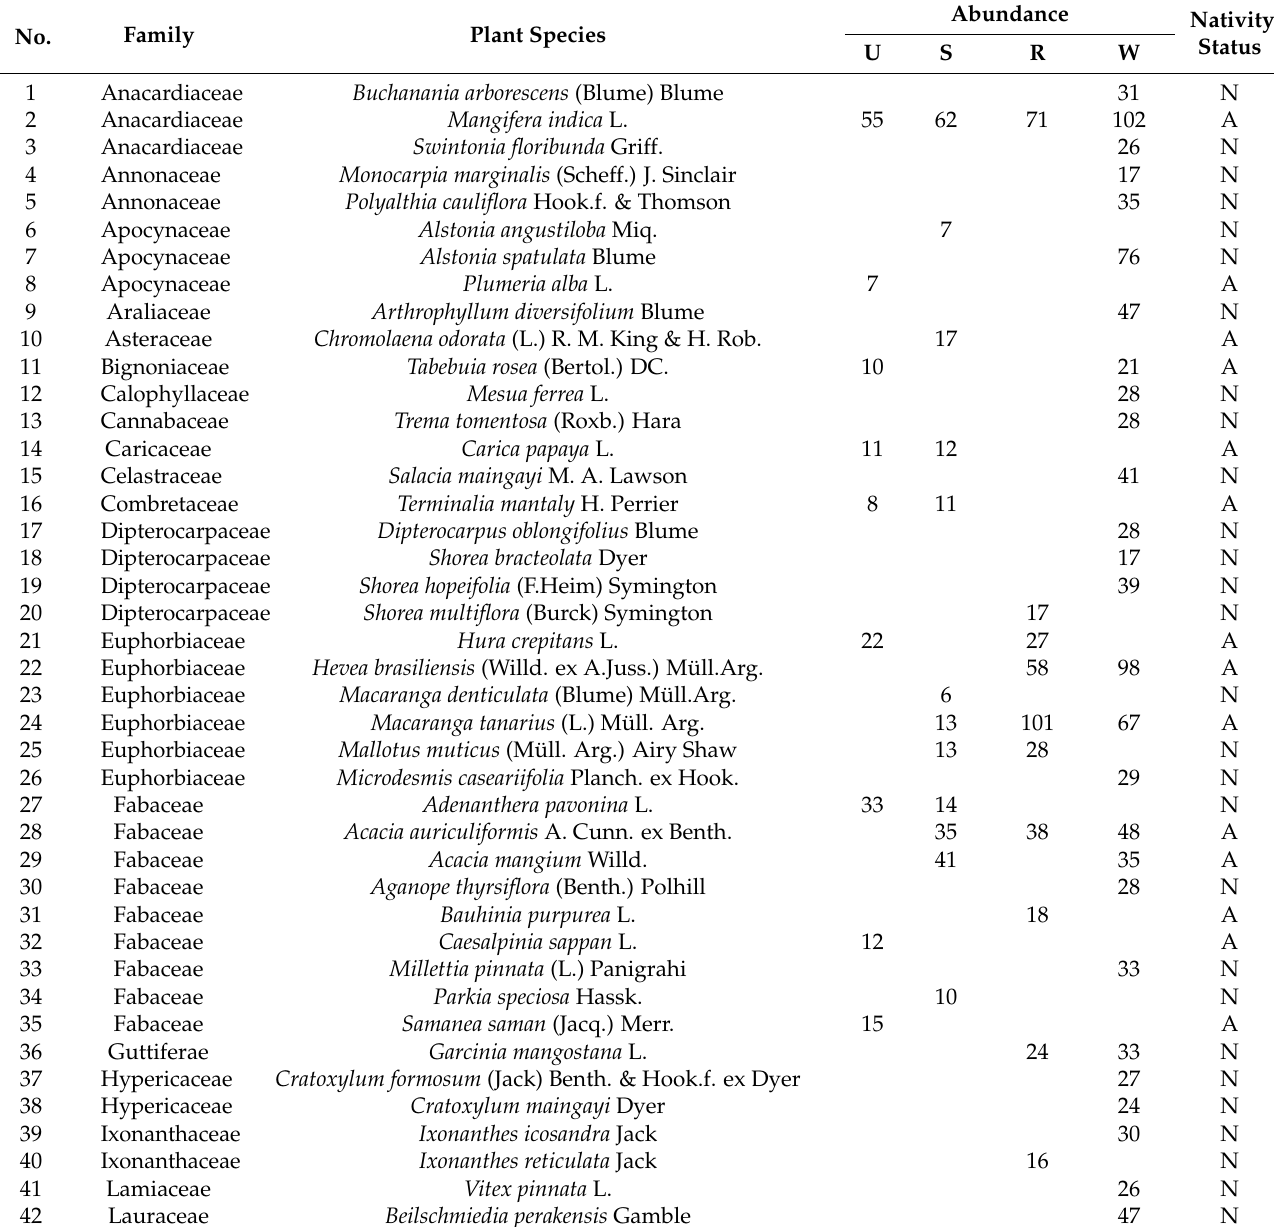
Table 1. Plant species and their abundance in urban, suburban, rural, and wildland areas in Ipoh, Perak,